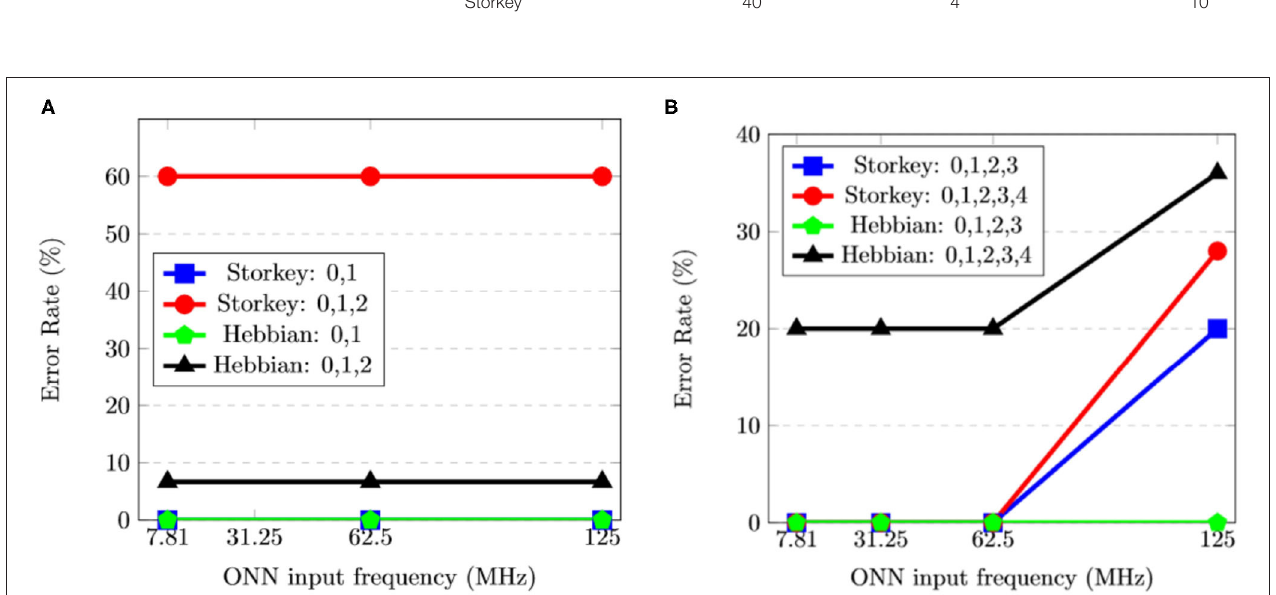
FIGURE 8 | Experimental results of the error rate (%) for various frequencies (MHz) and training configurations (learning rule and pattern combination) for (A) the 5 × 3 ONN, and (B) the 10 × 6 ONN.